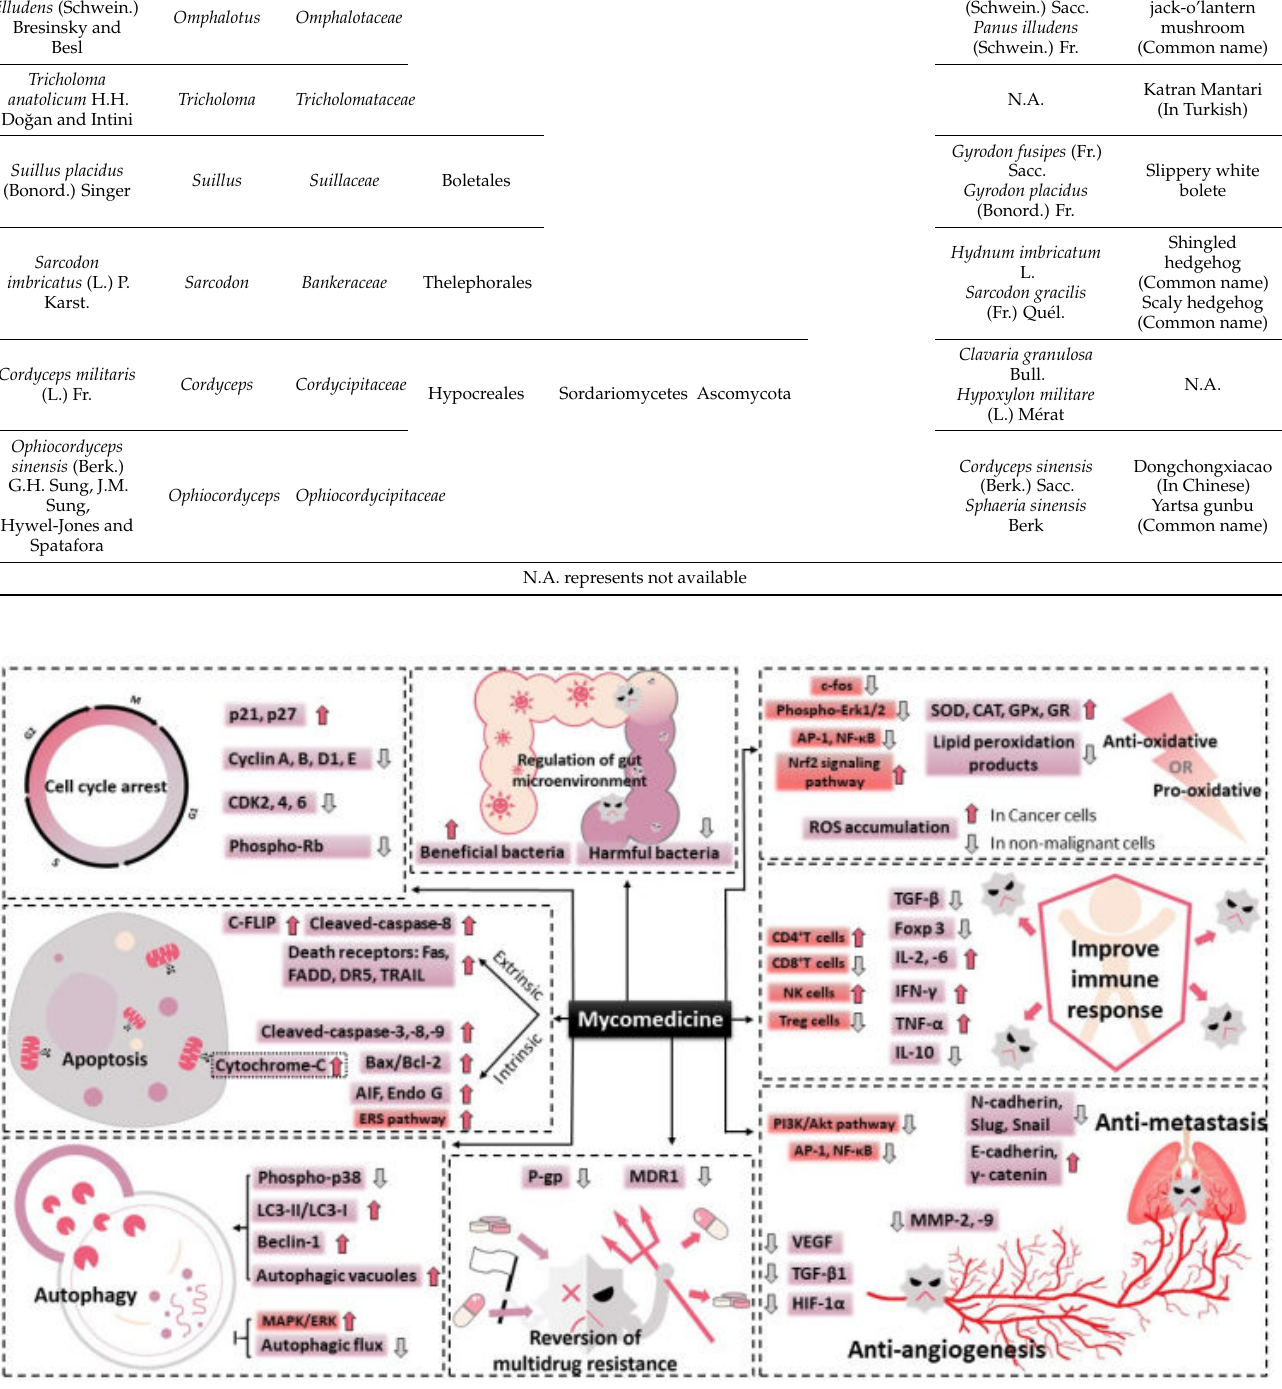
Figure 2. The schematic diagram of the anti-tumour bioactivities of mycomedicine. Mycomedicine demonstrated anti- cancer activities through regulation of cell cycle, apoptosis, autophagy, angiogenesis, oxidative stress, metastasis, multidrug resistance and gut microenvironment. “ ↑ ” indicates activate, promote, stimulate or up-regulate, while “ ↓ ” and “T” indicates inhibit, suppress, decrease or